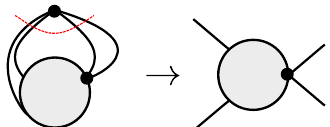
Figure 24: Excising quartic vertices which are incident to bubbles (left) leads to graphs with cuts on only one single channel (right). Note that a quartic vertex which is incident to a bubble is a cubic simple